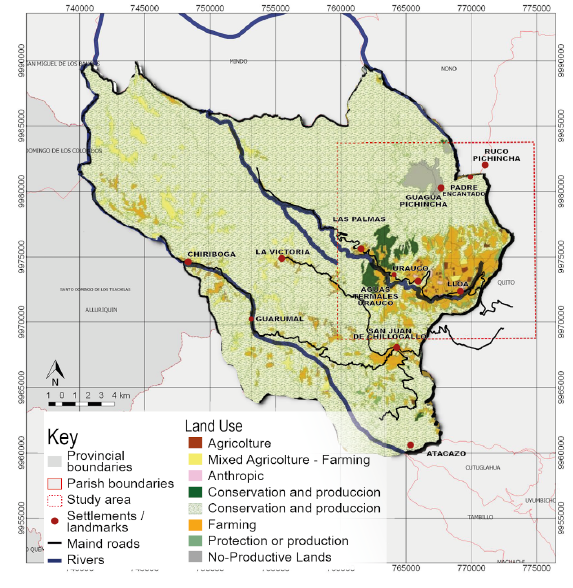
Figure 6: Land Use